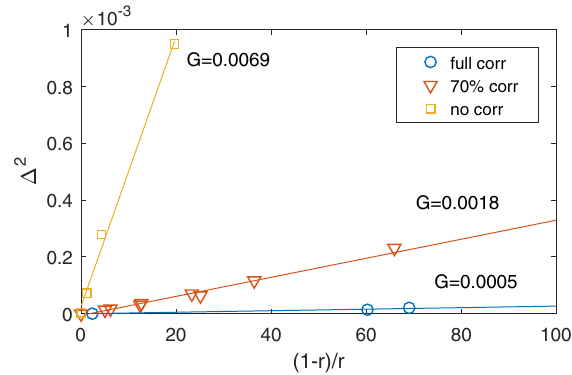
ϵ y ) and tune separation data ϵ x